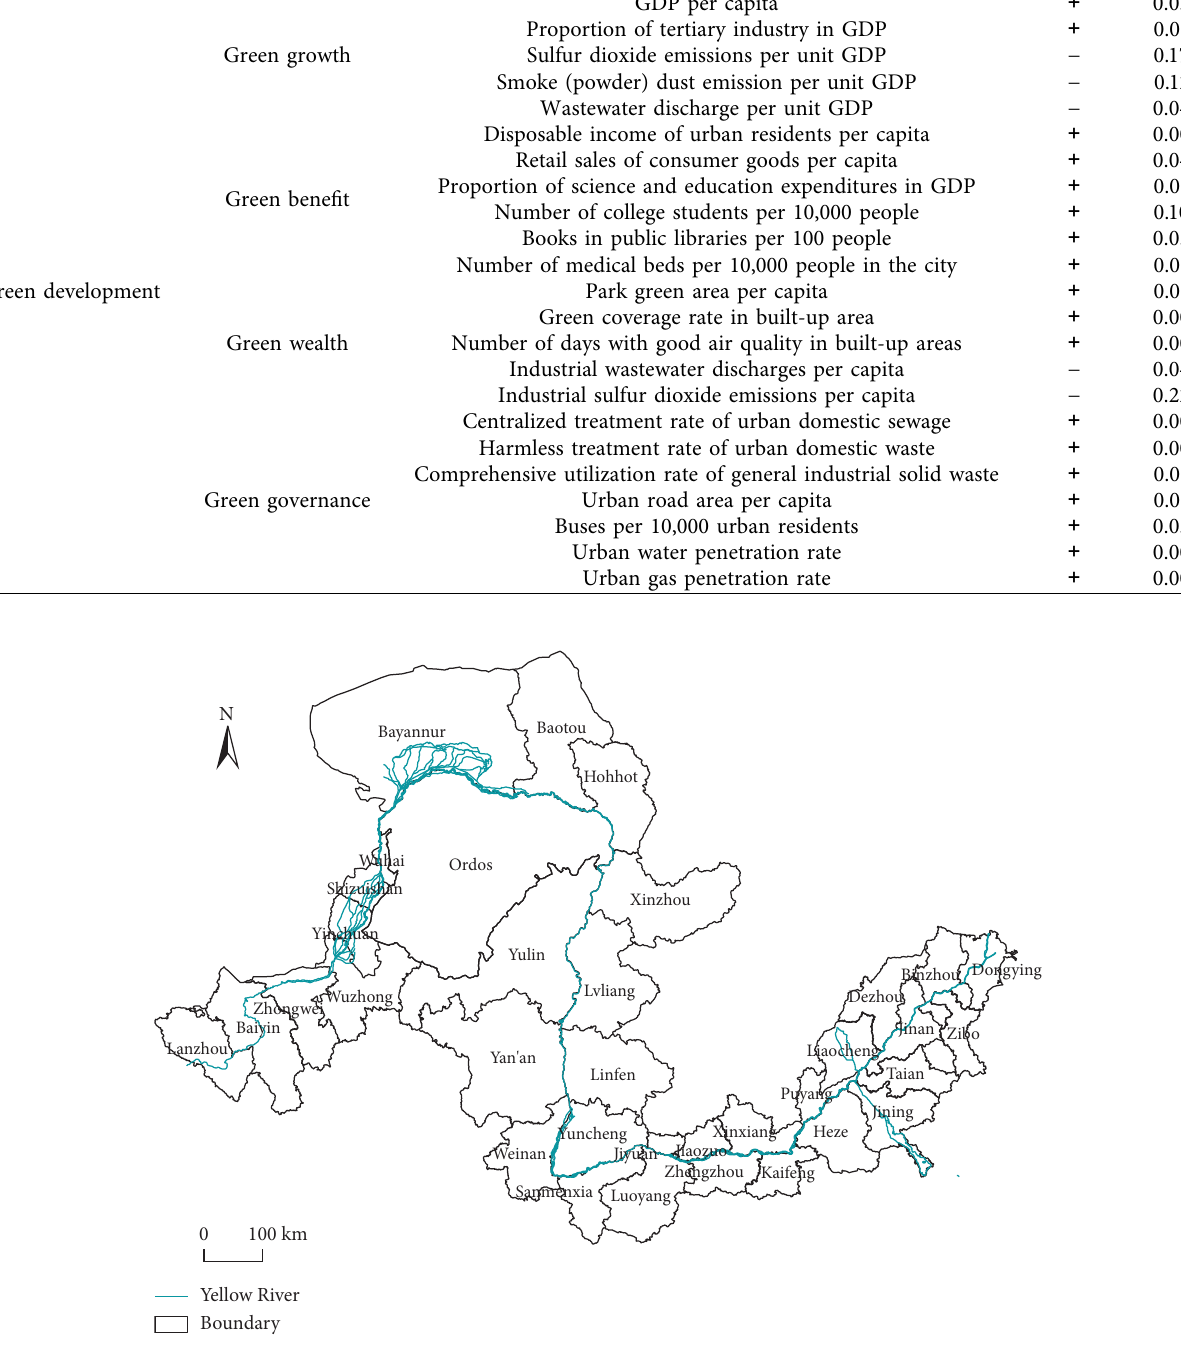
Figure 4: Sample area: the yellow river